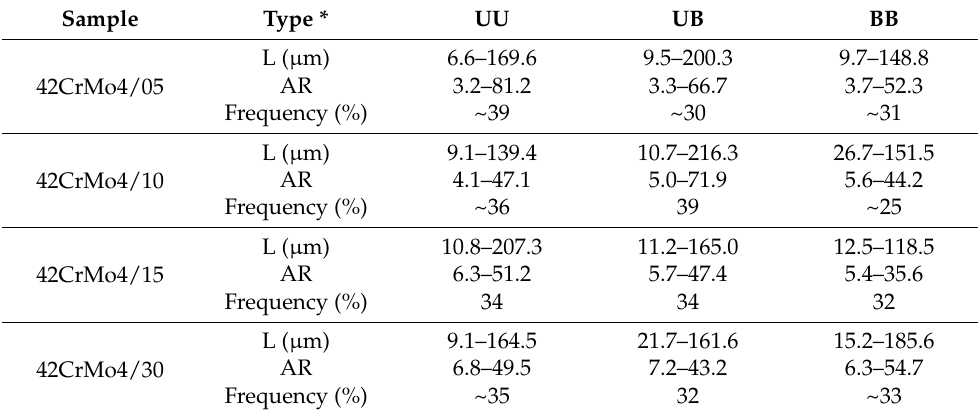
Table 10. Classification of different nonmetallic inclusions in rolled 42CrMo4 steel samples using Method 2.